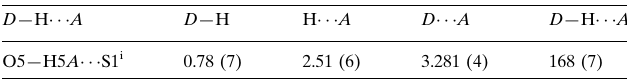
Hydrogen-bond geometry (A˚ , (cid:2)